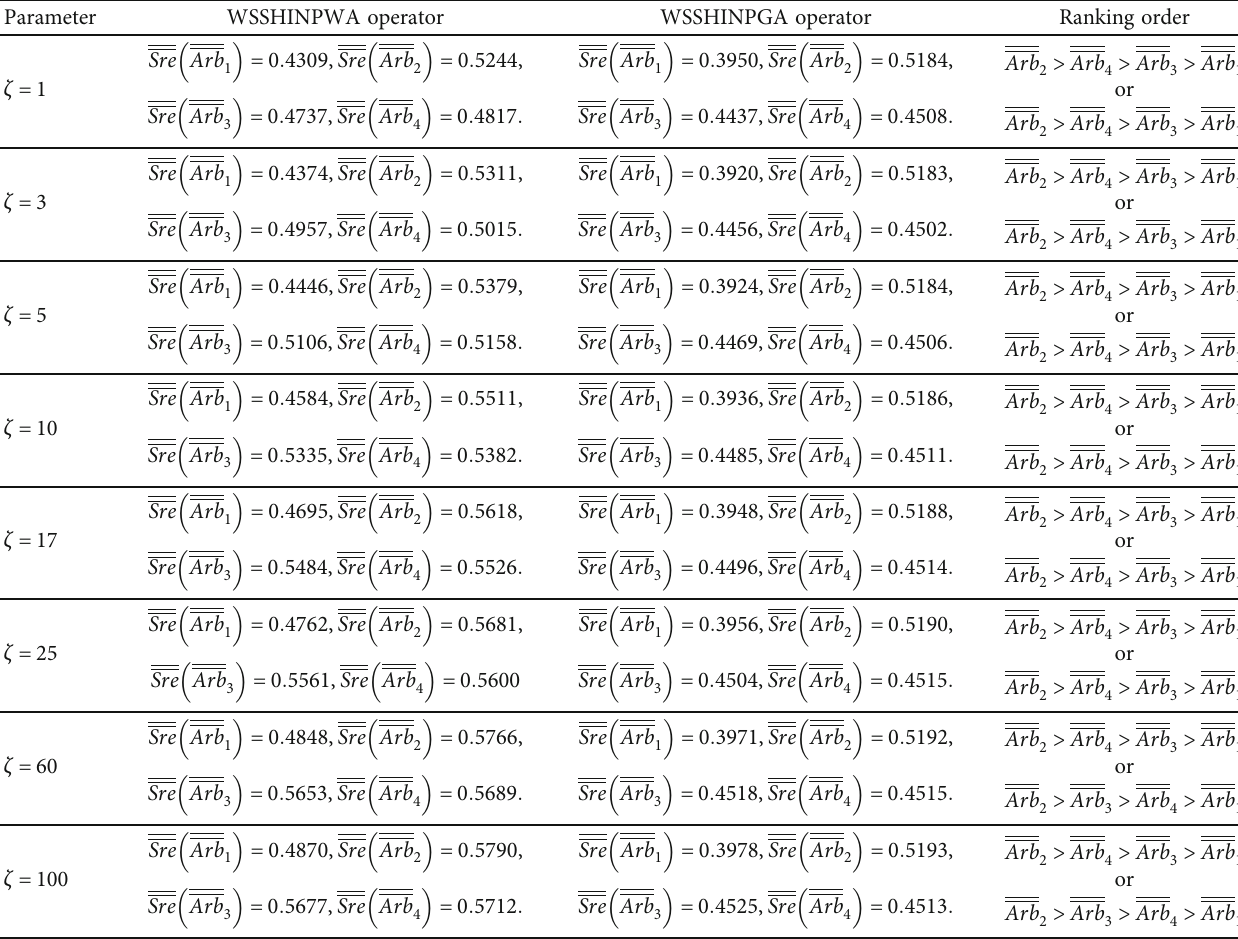
Table 4: E ff ect of the parameter ζ on decision